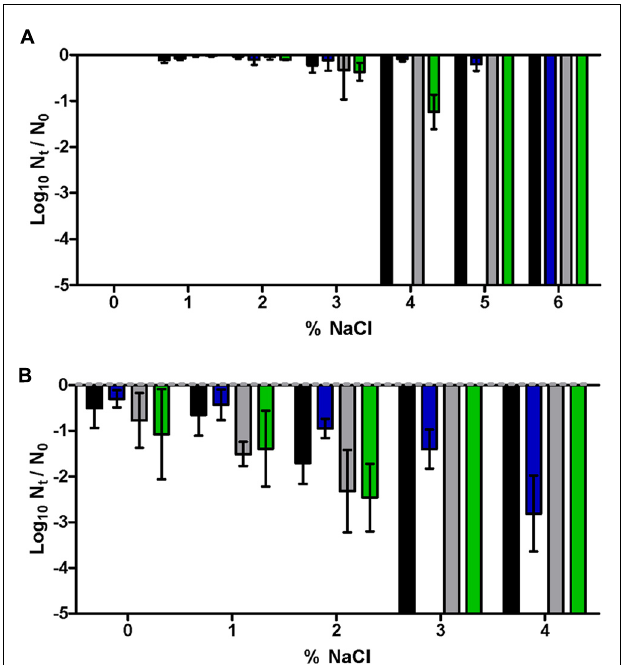
FIGURE 2 | Log 10 cycles of survival fractions of untreated (A) or treated for 10 min at 55 ◦ C in M9 broth (B) of E. coli BW25113 WT (black, blue bars) or (cid:49) proP (gray, green bars) after incubation in the absence (black, gray bars) or presence (blue, green bars) of betaine 1 mM in the M9 agar of different NaCl concentrations. Error bars represent standard deviation of the mean from three replicates.